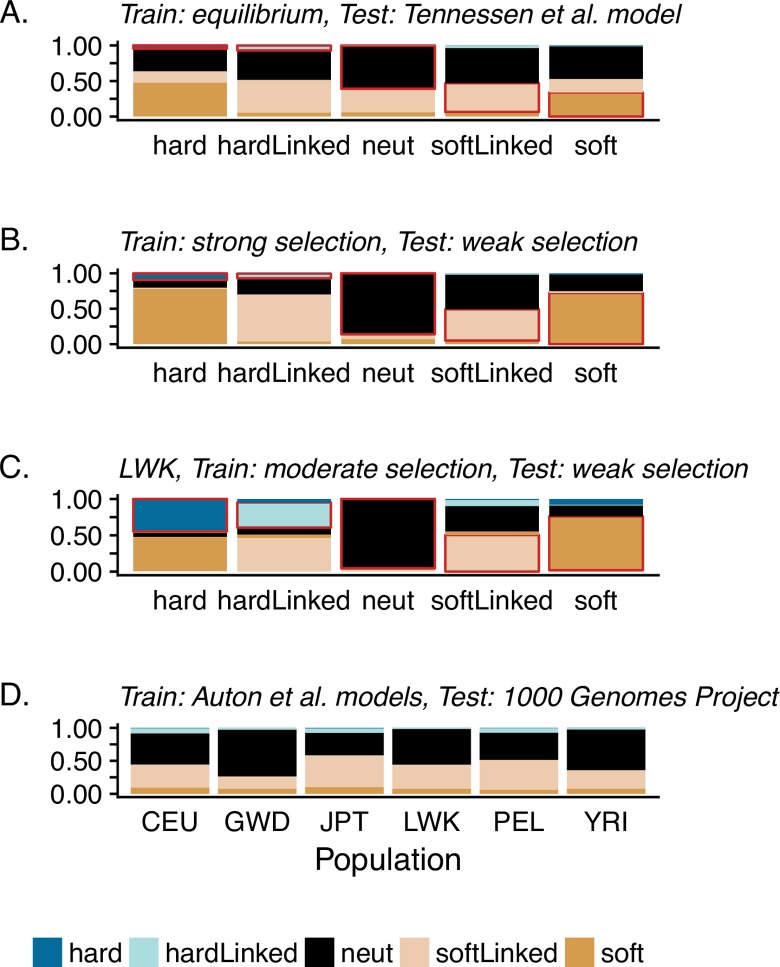
The performance of S/HIC.Stacked bar plots depict the probabilities of model classification by S/HIC. Each vertical bar represents 1000 simulated datasets of each category (where the true models are given on the x-axis in panels a-c (i.e., hard, hard-linked, neutral, soft-linked, and soft)). Within each bar, colors represent the proportion that were assigned to each category by S/HIC, and the red outline indicates the correct classifications (i.e., true positives). (a) The plotted results of S10 Fig of Schrider and Kern [12], examining classification performance under the Tennessen et al. [16] African human demographic model, when the training data assumes an equilibrium model. (b) Results when the strength of selection is mis-specified—both test and training data were simulated under an equilibrium demographic model, where the true dataset is drawn from a moderate selection model (2Ns ~ U[25, 250]) and the training dataset from a strong selection model (2Ns ~ U[250, 2500]). (c) Performance when the simulated LWK population experiences weaker selection (2Ns ~ U[10, 1000]) than the training set (2Ns ~ U[166, 3333]). (d) The classification ratios of the empirical 1000 Genomes project data presented by Schrider and Kern [11] (also depicted in their Fig 2), which they trained upon a history of population size change as interpreted from PSMC by Auton et al. [17]. From left to right on the x-axis, the populations presented are from individuals sampled in North America of Northern and Western European ancestry (CEU), Gambia (GWD), Japan (JPT), Kenya (LWK), Peru (PEL), and Nigeria (YRI).